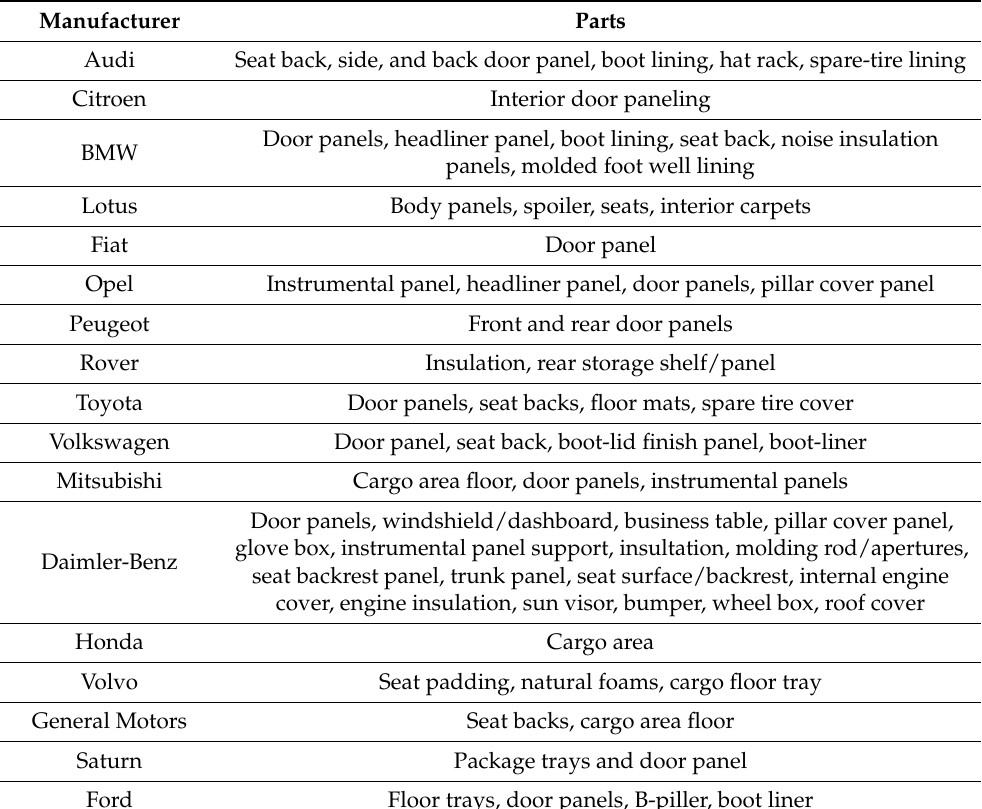
Table 2. Automotive use of natural-fiber-reinforced polymer